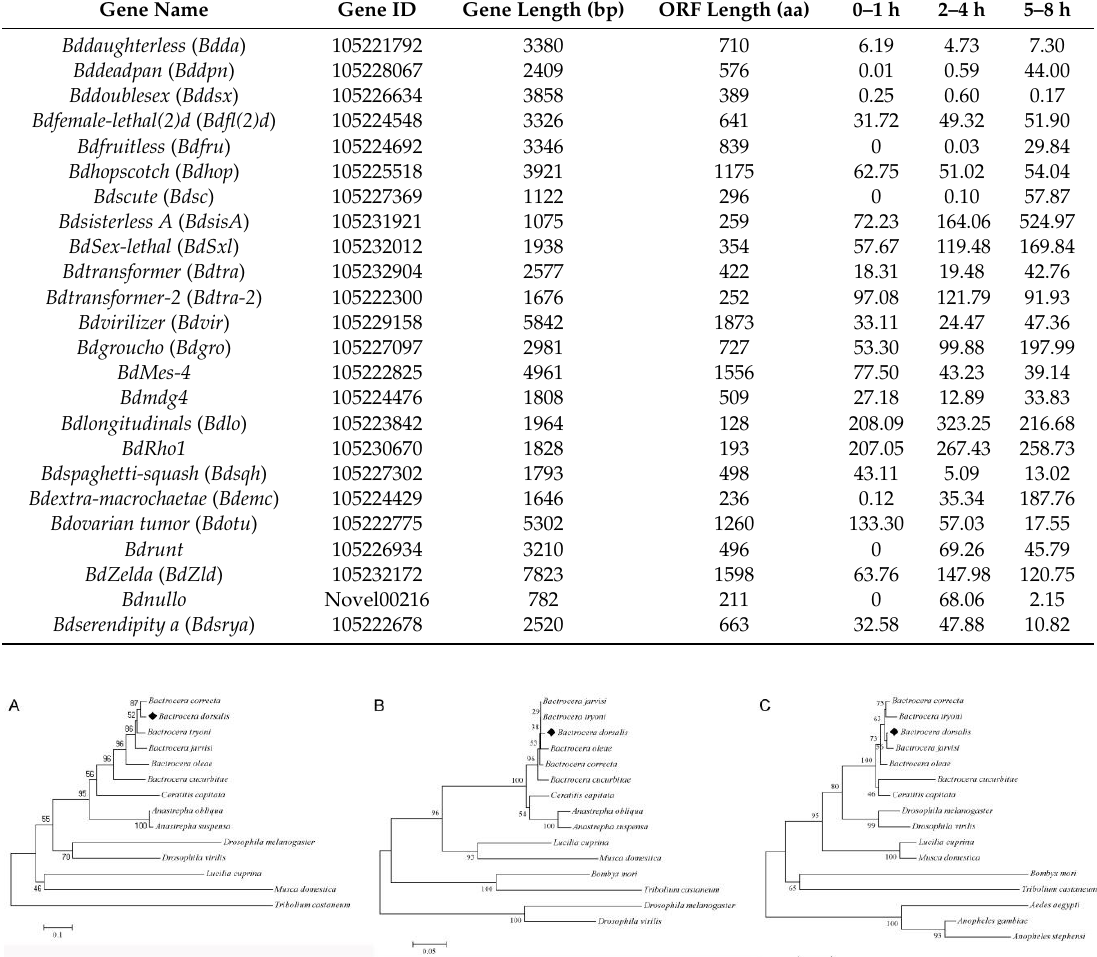
Table 3. Expression profiles of the sex-determination and cellularization transcripts identified in the B. dorsalis early embryo transcriptomes. Expression in each sample is reported as the normalized FPKM value.